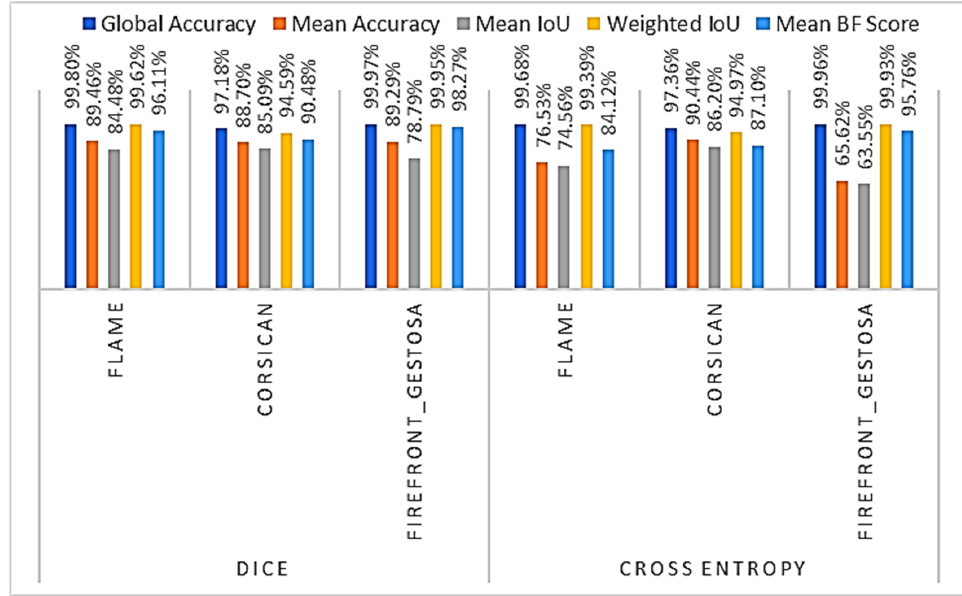
Figure 9. The overall metrics, over the three sets of data (FLAME, Corsican, and Firefront_Gestosa), were gathered using Cross entropy and Dice loss functions with Deeplabv3+ with ResNet-18 as a backbone.